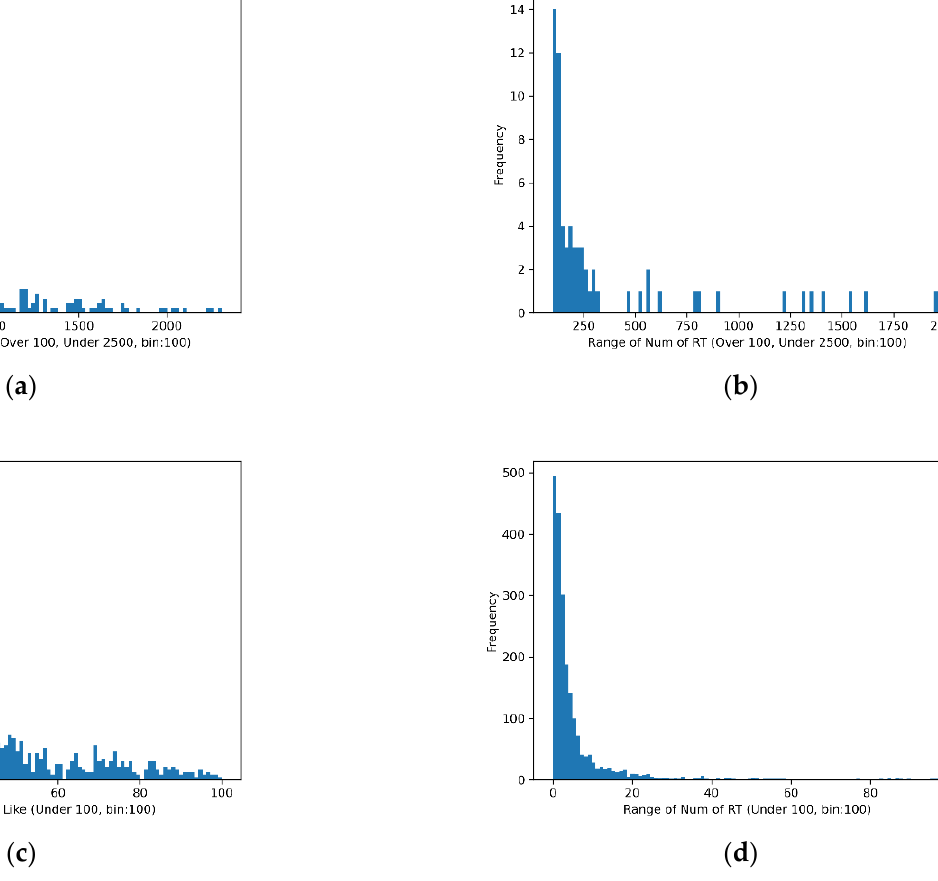
Figure 3. Distribution of number of likes and retweets; ( a ) number of likes (over100), ( b ) number of RTs (over100), ( c ) number of likes (under100), ( d ) number of RTs (under100).